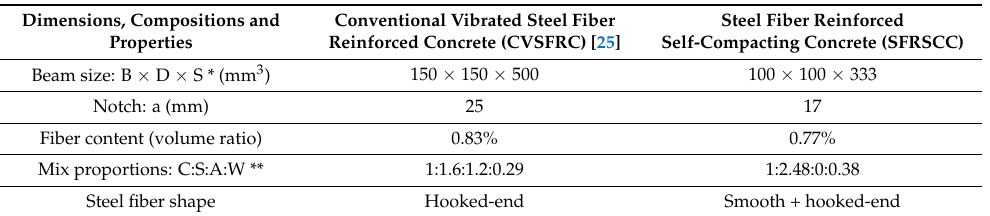
Table 6. Comparison of experimental